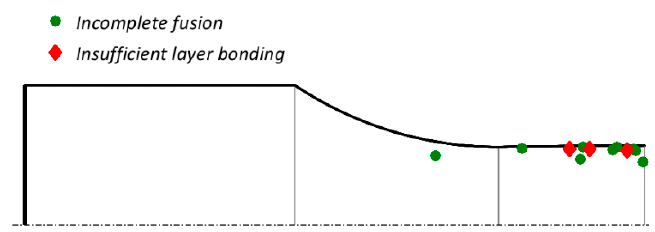
Figure 4. Distribution of defects along the longitudinal and radial directions.